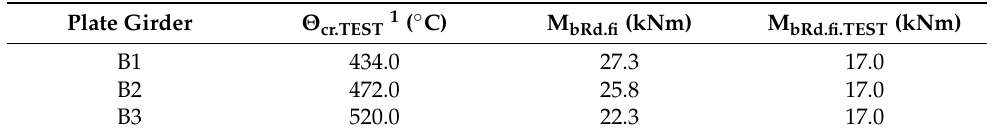
Table 6. Load bearing capacity (buckling resistance). M bRd.fi.TEST —experimental test, M bRd.fi — analytical